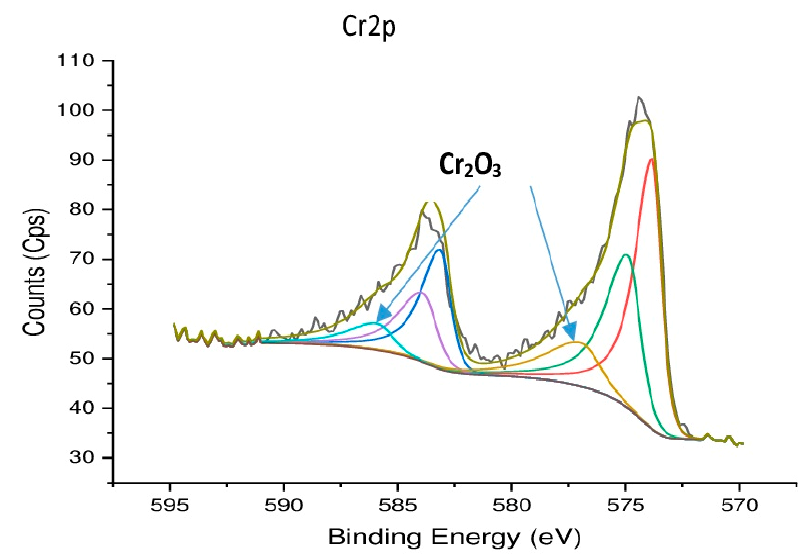
Figure 11. High-resolution XPS data of worn rake surface of CrN coated insert, Cr2p spectrum. Reproduced from [36], with permission from Elsevier, 2020.